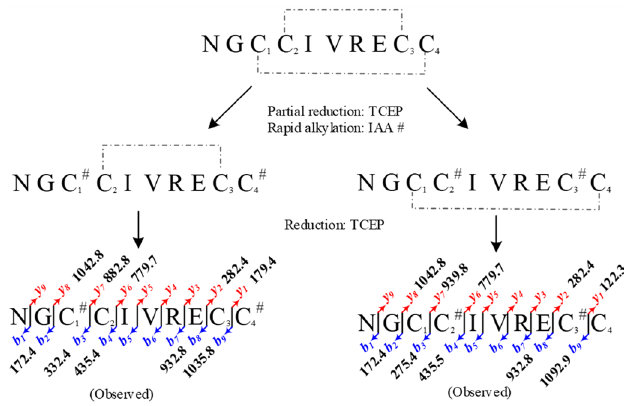
Figure 7. Overview of Bn5a-cysteine connectivity determination and highlight of the key